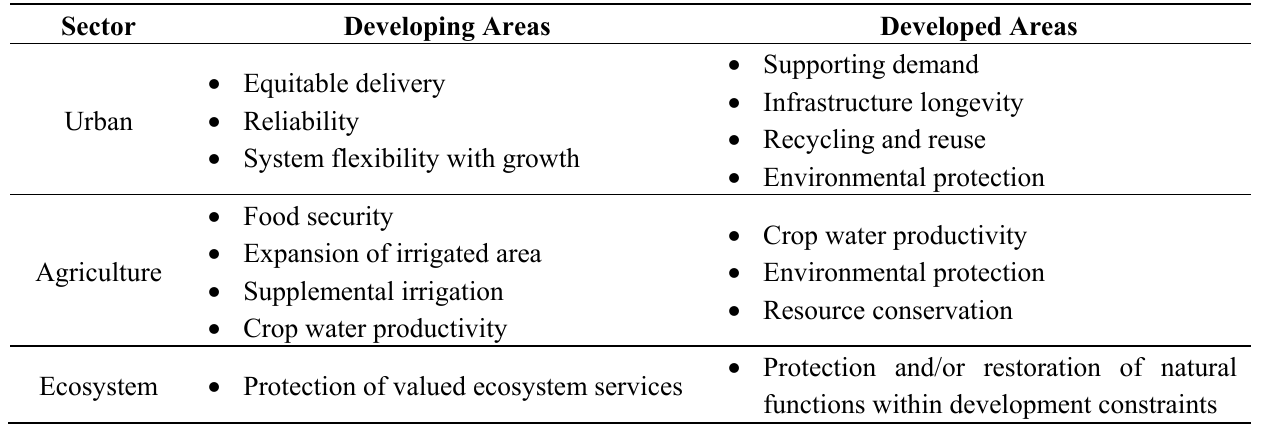
Table 2. Primary sustainable water management objectives.